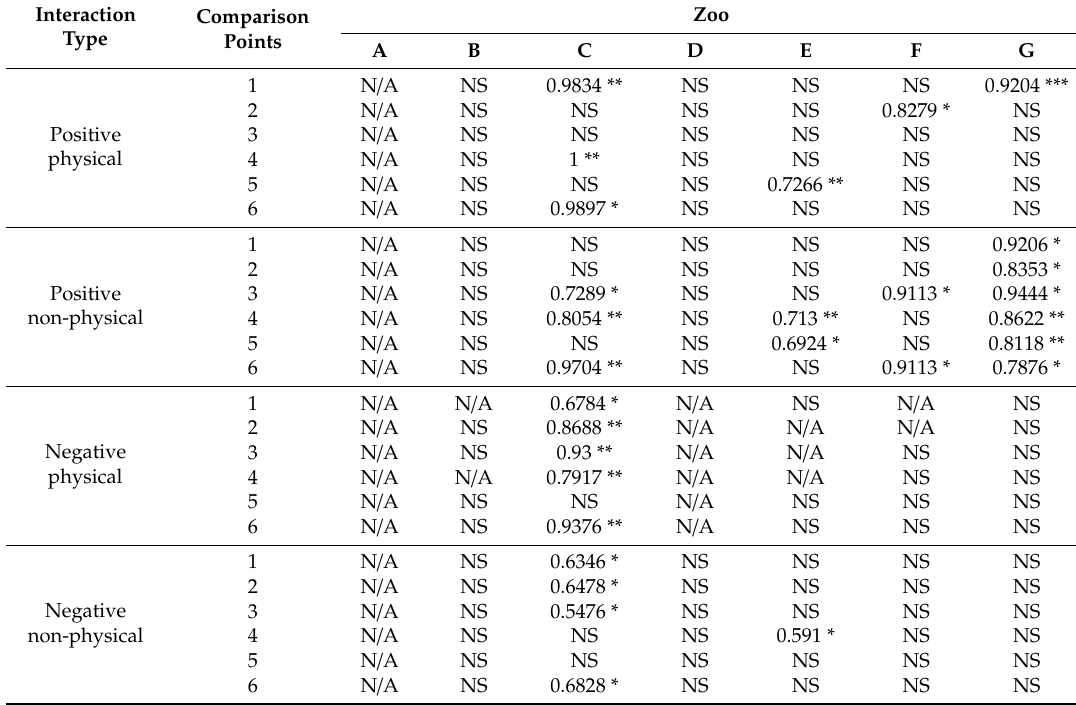
Table 7. Mantel test correlation scores showing stability over time for social interactions in the study